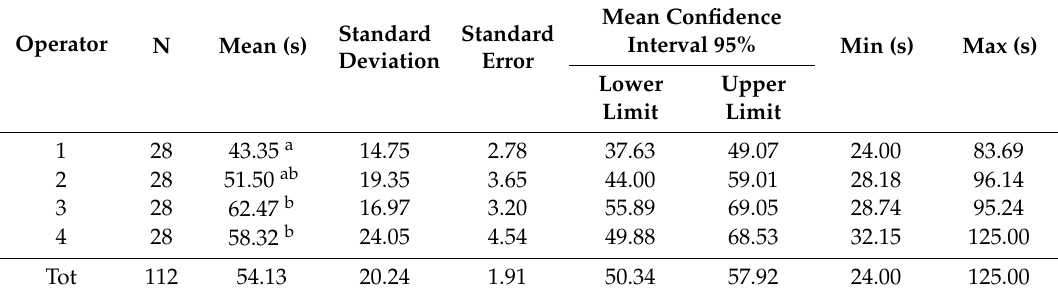
Table 2. Drilling time